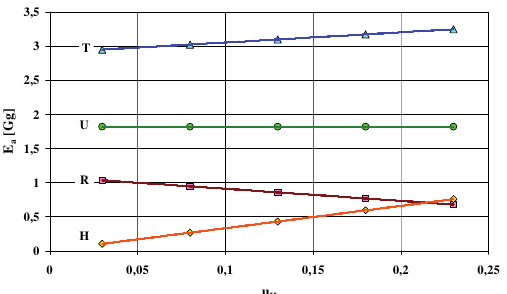
Fig. 12. Dependence of the national annual emission of particulate matter PM2.5 from tribological elements of passenger cars upon the road length travelled under the following model traffic conditions: U – urban, R – rural, H – on highways and expressways as well as T – under all conditions